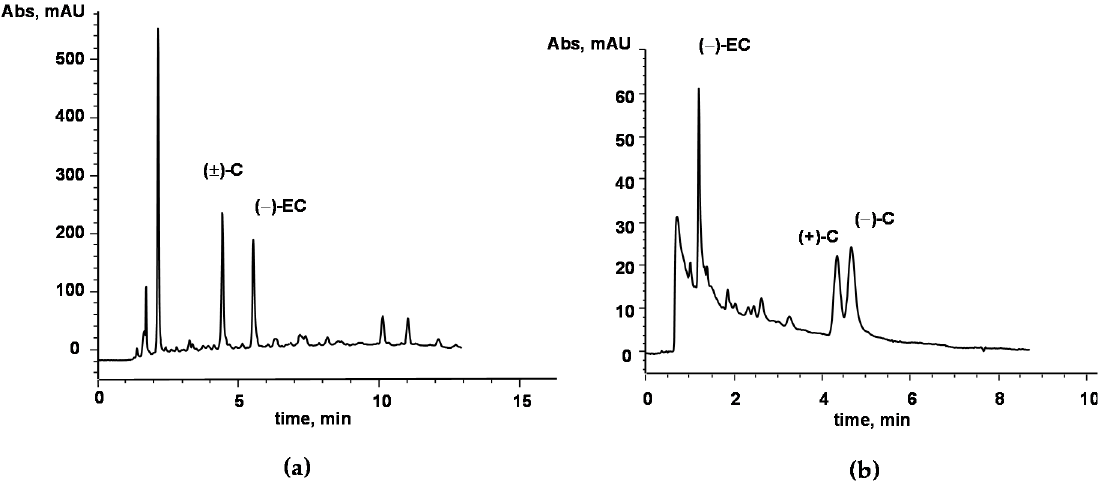
Figure 1. ( a ) HPLC chromatogram of a sample (aqueous extract) of Acacia catechu decoction. The method allows separation of the major catechins; namely, ( ± )-C, ( − )-EC, ( − )-ECG, ( − )-EGC, ( − )-EGCG and ( − )-GCG. In the sample, only ( ± )-C and ( − )-EC were found at levels higher than the limit of quantitation. ( b ) CD-MEKC of the same sample as in A). The method allows for the separation of the major catechins, as in the HPLC method. In addition, enantioseparation of ( ± )-C was achieved, revealing the presence of a significant amount of non-native ( − )-C. HPLC and CD-MEKC conditions are described in the Materials and Methods section.